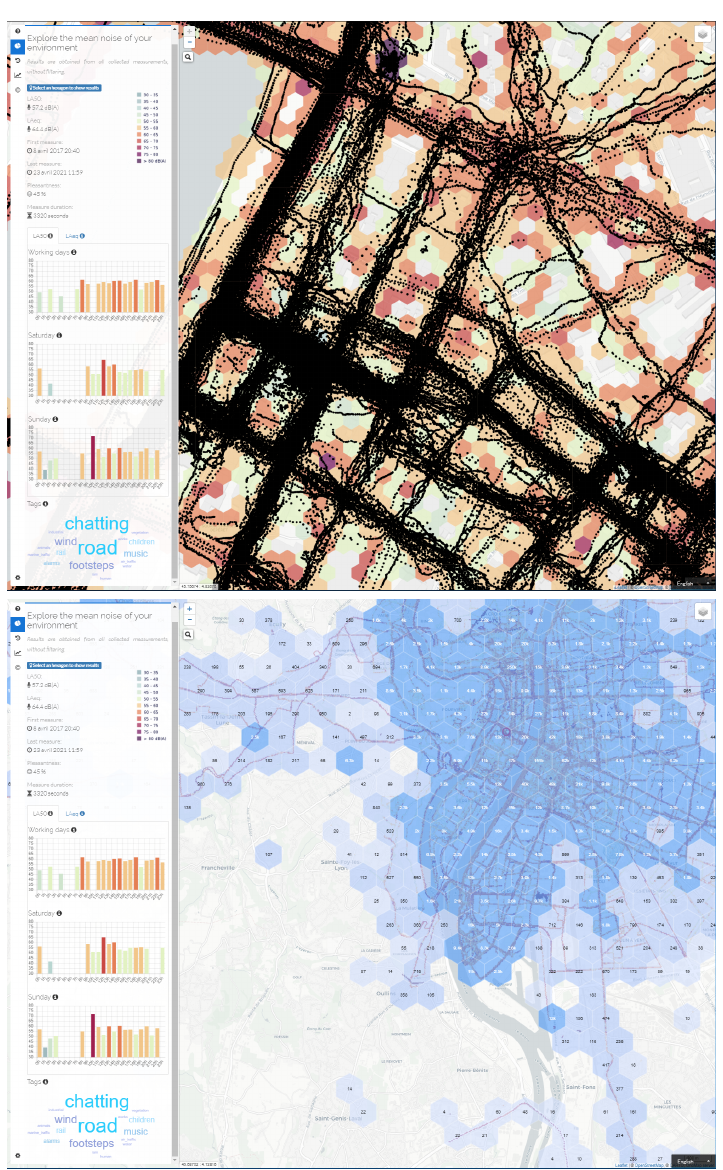
Figure 2. Screenshots of the NoiseCapture map website. Example of collected data representation, on the Lyon French city (from https://noise-planet.org/map_noisecapture/index.html#18/45.7538 7/4.84052/ (accessed on 15 July 2021)), at a higher ( up ) and lower ( down ) zoom